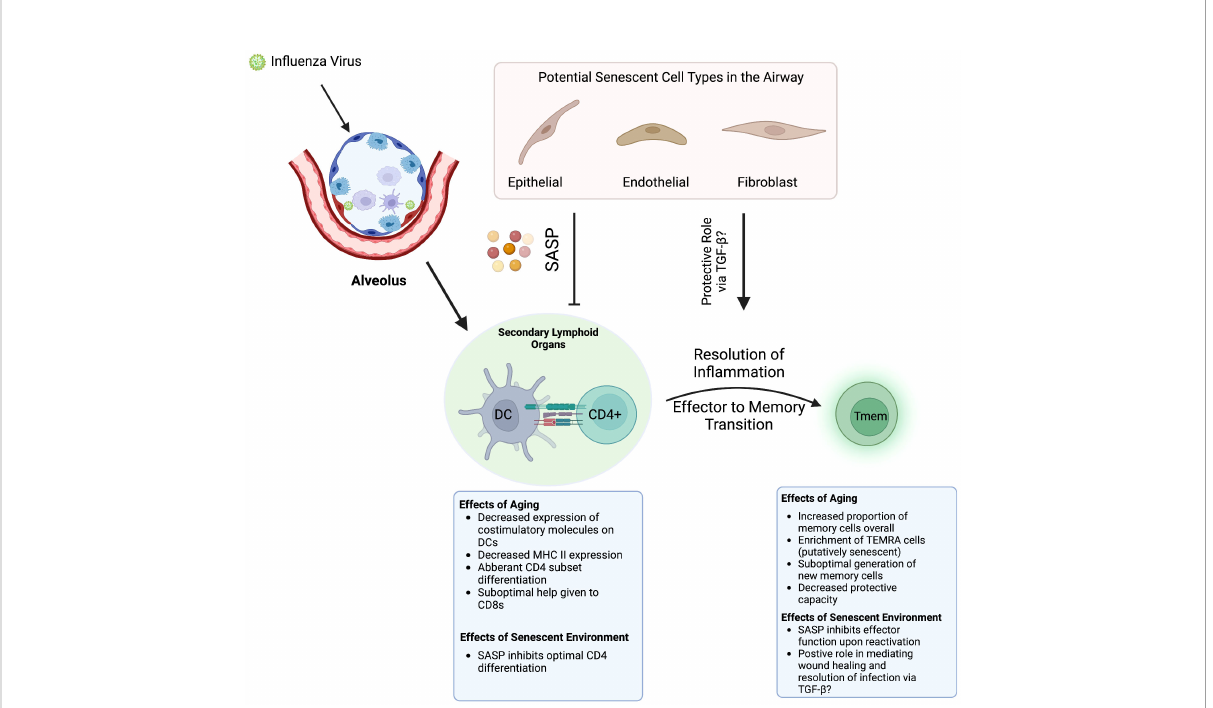
FIGURE 1 How Aging and Senescence Regulate Antiviral T Cell Responses. When a fl u infection occurs, APCs such as DCs present antigen to naïve CD4 T cells, which requires costiumulation and a conducive cytokine milieu. Aging results in various defects in this process and senescent cells alter the milieu by secreting SASP factors. These perturbations result in suboptimal responses in both the CD4 and CD8 T cell compartments. Whenever the pathogen is cleared, the return to homeostasis and the effector to memory transition is also affected. Especially in the CD8 compartment, memory cells generated following infection are also deleteriously affected by aging. It is possible that SASP may play a role in regulating memory differentiation via its wound healing activities and secretion of TGF- b . Created with